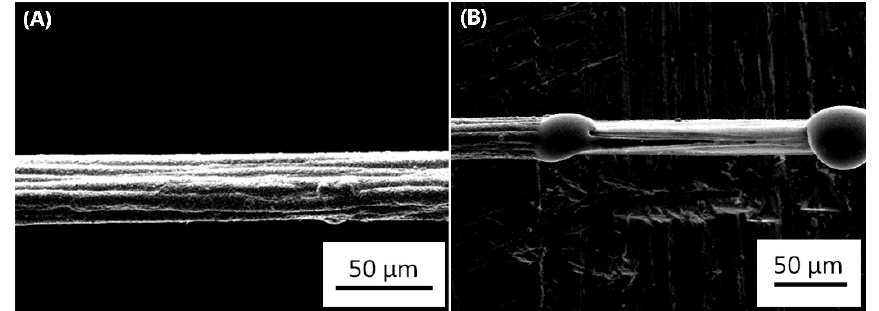
Figure 4. Failure due to electromigration in a graphene-copper composite. ( A ) is the line prior to applying a high current density whilst ( B ) is the same line after the failure. The image belongs to the authors.